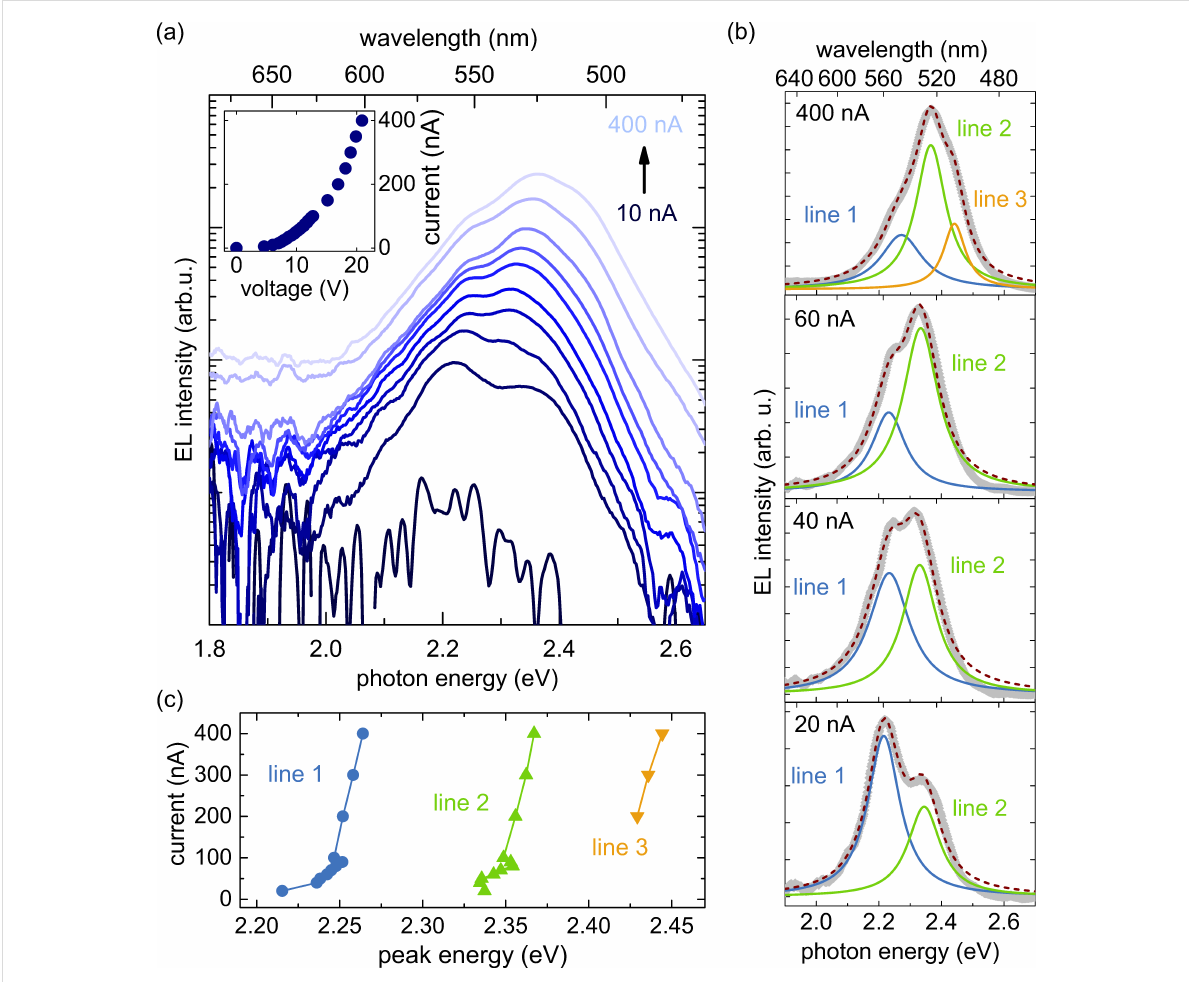
Figure 3: (a) EL spectra of NW C for currents in the range of 10–400 nA. The inset shows the corresponding current–voltage characteristic. (b) The different line profiles in the spectra for driving currents of 20, 40, 60, and 400 nA (data plotted as gray lines) were fitted by Lorentzian curves. The cumulative fit curves are displayed as purple dashed lines. (c) The graph shows the peak energy extracted from the fits of the different line profiles in (a) for driving currents from 20 to 400 nA. For clarity the x -axis with the driving current is plotted vertically. Moreover, the lines connecting the different data points for each emission line are a guide to the